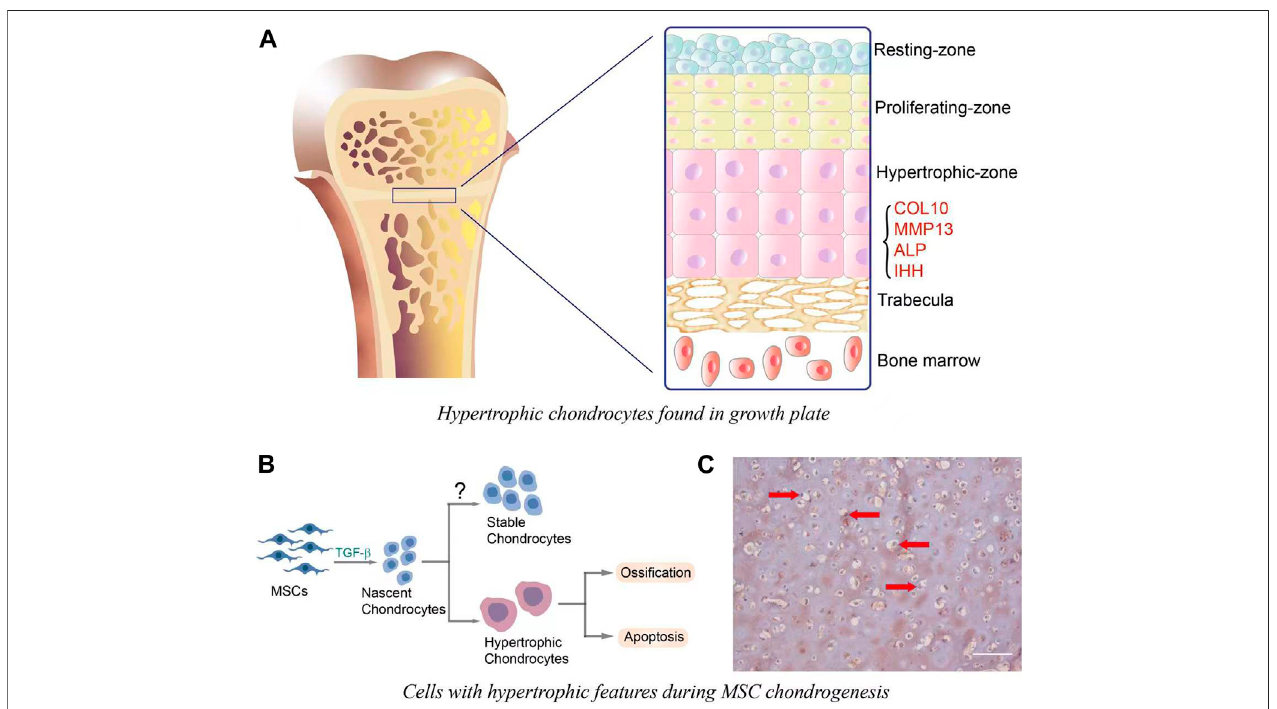
FIGURE1 | (A) . Hypertrophic chondrocytes observed in growth plate. Cells in the resting-zone, located at the end ofbone, are round and small. Proliferatingzone isadjacenttotheresting-zone,andchondrocytesinthiszonehavetheabilitytoproliferateanddifferentiate.Thedifferentiationisalsoaccompaniedbytheincreaseofcell size and the acquisition of hypertrophic phenotype, which is mainly characterized by the expression of hypertrophic markers, such as COL10, MMP-13, ALP, and IHH. (B) . In vitro MSC chondrogenesis and hypertrophic transition. In the initiation stage (~7 days) of chondrogenesis, MSCs are differentiated into nascent chondrocytes, which then undergo hypertrophy and the following ossi fi cation or apoptosis. It is important to note that nascent MSCs-derived chondrocytes may have thepotentialtobecomestablechondrocytes,yetthishasnotbeencompletelyachieved. (C) .COL10immunostainingforMSCs-ladenhyaluronicacid(HA)constructthat was subjected to 21 days of chondrogenic culture. The hypertrophic chondrocytes were characterized by large cell volume and the deposition of COL10 (brown staining, red arrows). Scale bar = 100 μ m.